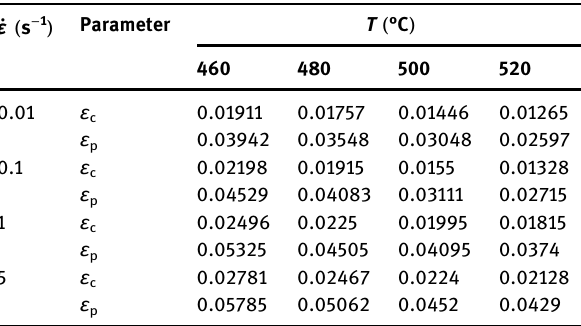
Table 3: Critical strain ( ε c ) and peak strain ( ε p ) of DRX under dif - ferent deformation